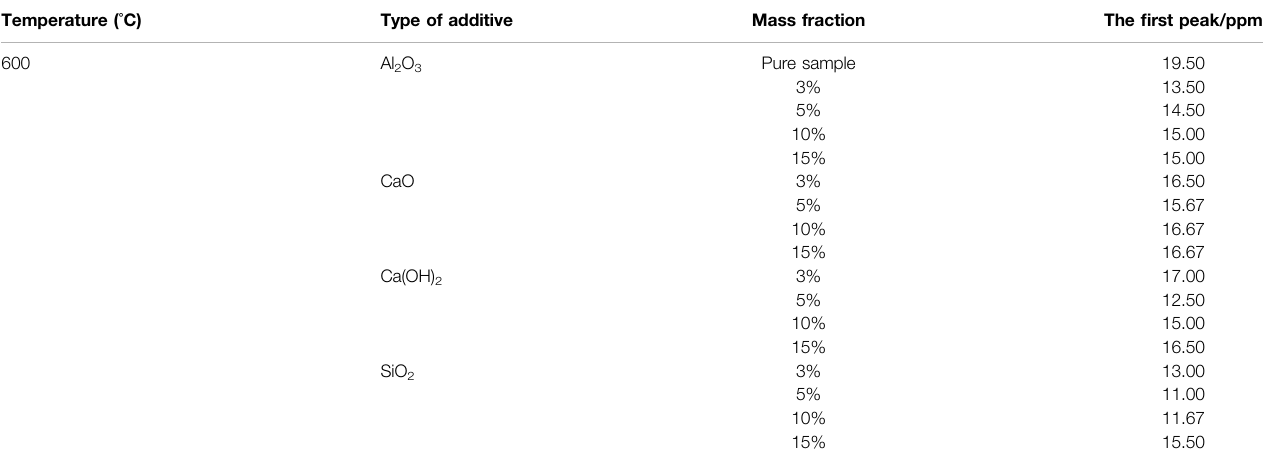
TABLE 2 | The fi rst NO x emission peaks from the combustion of fast-growing grass using different mass fractions of additives at 600 ° C. Temperature ( ° C) Type of